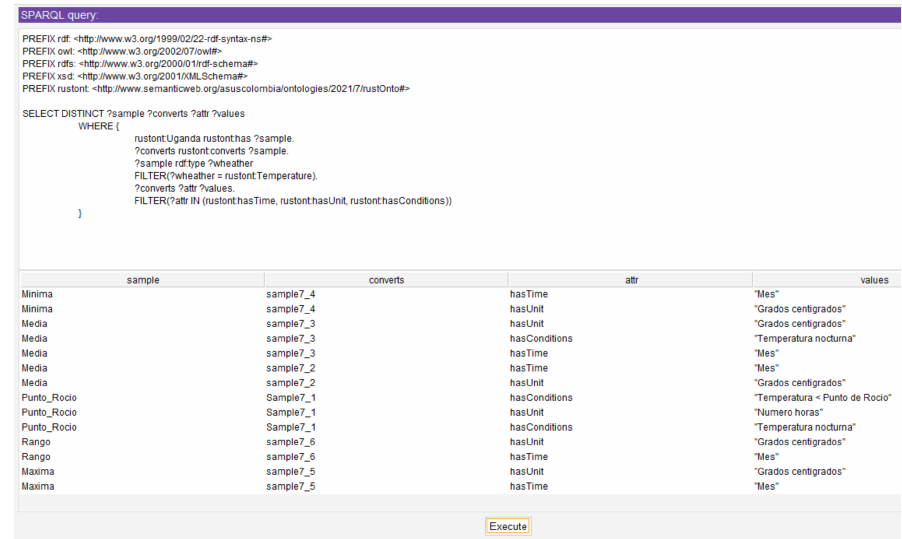
Figure 8. Query details the attributes of the valid samples for the query in Scenario 4 (Protégé 5’s Pellet reasoner, execution time was 264